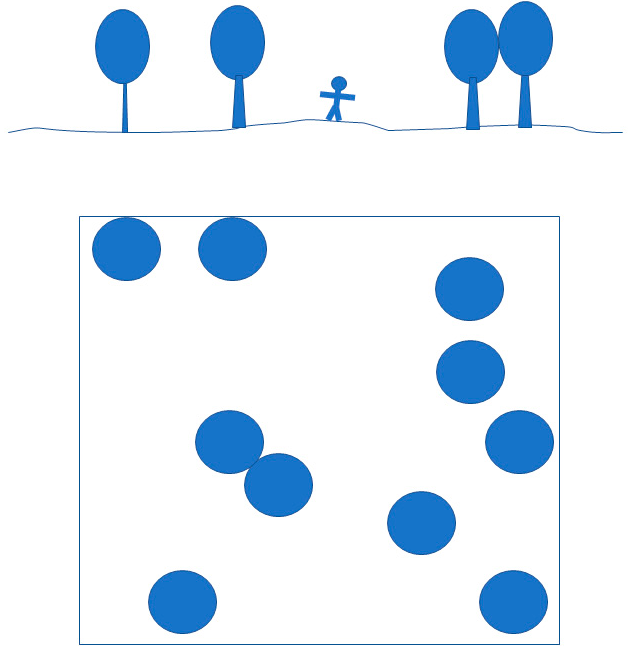
Figure 2. Schematic of the Global Forest Resource Assessment definition of a “forest”; area > 0.5 ha, trees > 5 m, canopy cover > 10%.